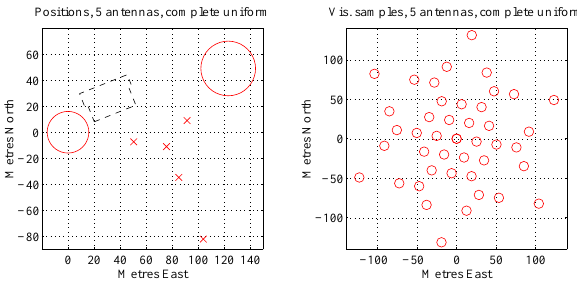
Fig. 6. A configuration for five passive receiving antennas, in the same format as Fig. 2. This is the same pattern as in Fig. 4, with an added receiving antenna at the third vertex of the outer